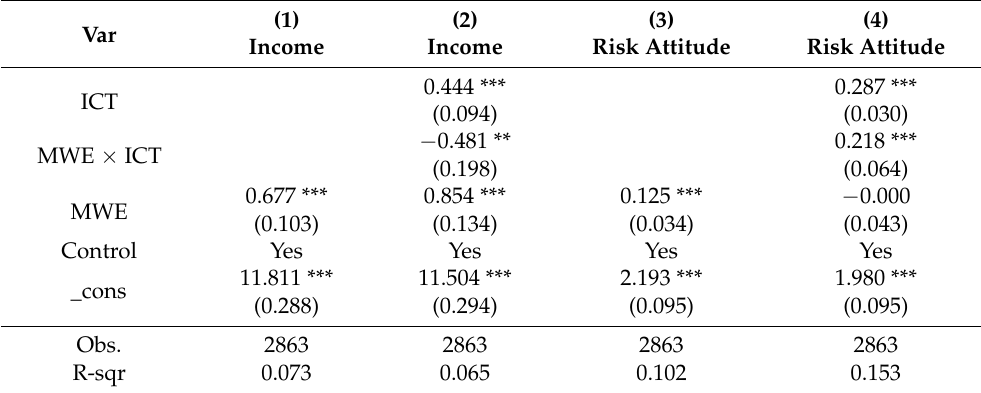
Table 5. The moderating effects of ICT adoption.